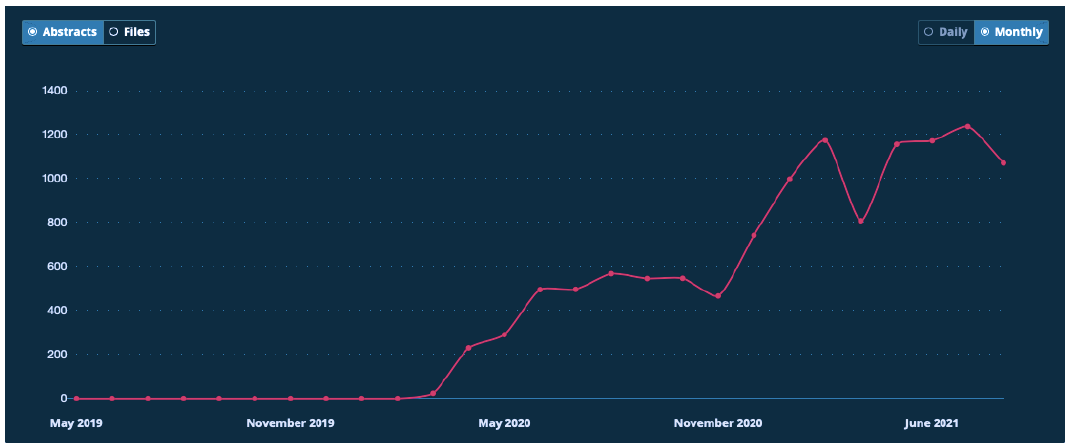
Figure 2 - Abstracts views of APN website in the past two years